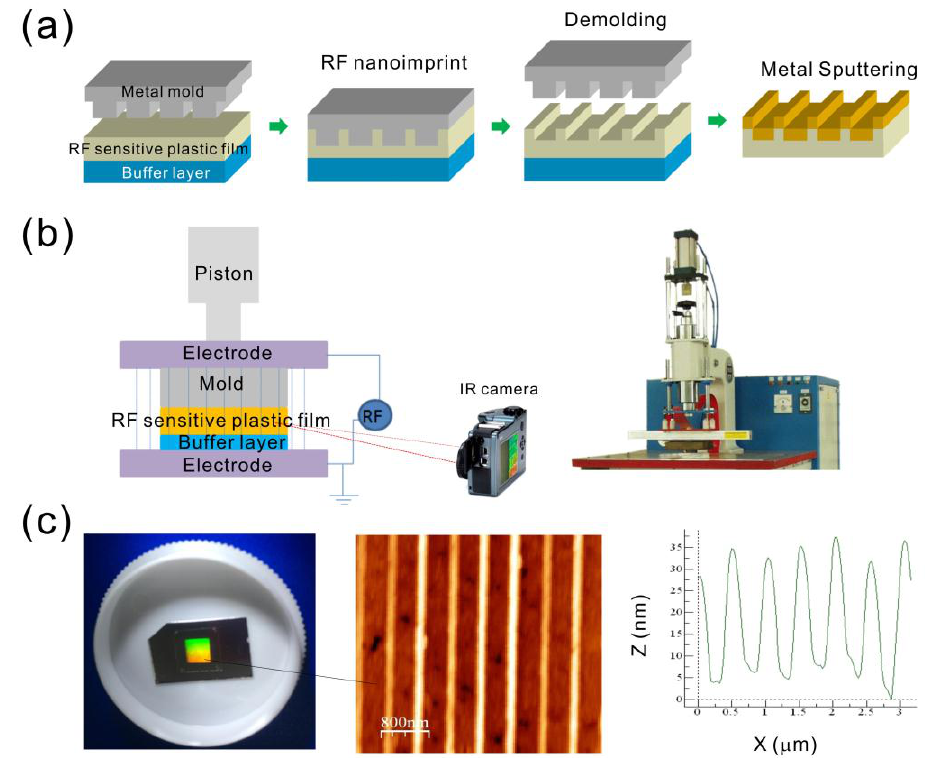
Figure 2. ( a ) The fabrication process for the capped metallic nanoslits using the RF-heating nanoimprinting method and metal coating; ( b ) setup of the radio-frequency (RF)-heating method. The commercial RF machine is shown in the inset; ( c ) the optical (left), AFM (middle), and cross-sectional profile (right) of the capped aluminum nanoslits. The RF power: 2.17 KW, RF time: 9 s, pressure: 106 psi.